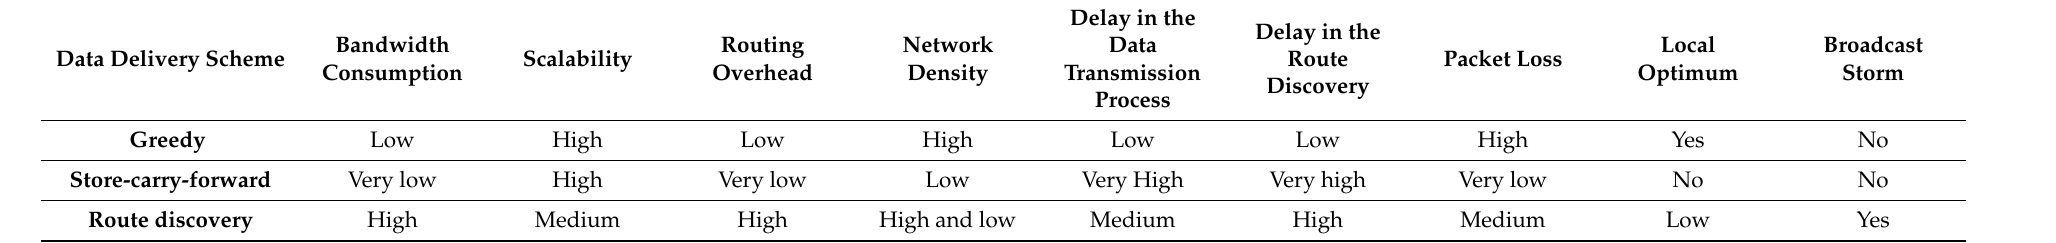
Table 5. Comparison of data delivery